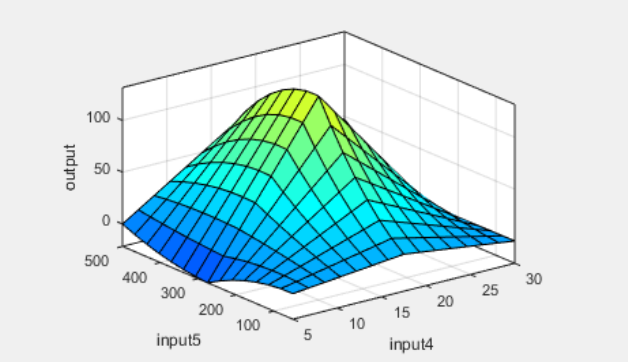
Figure 16. Surfview of output